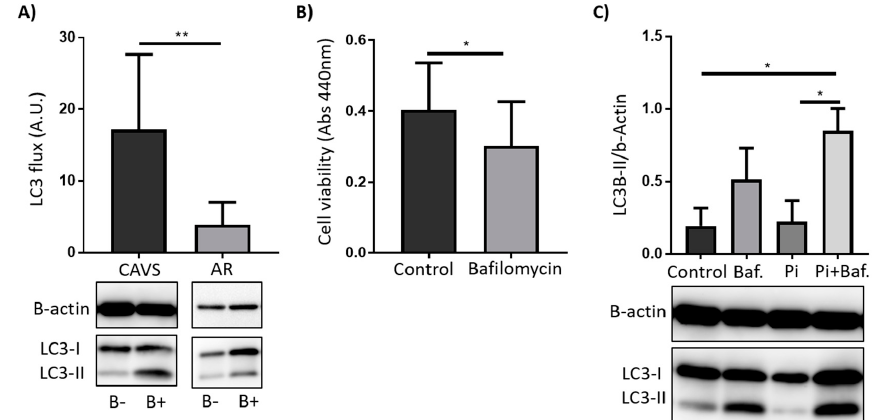
Figure 3. Autophagic activity is differentially expressed in AR and in CAVS and serves as a survival mechanism in valvular interstitial cells (VICs). ( A ) Immunoblotting against LC3-I and LC3-II in human VICs treated for 2 h with bafilomycin (1nM) (B+) or vehicle control (DMSO) (B-), including quantification of the autophagic flux measured as the LC3-II ratio between (B+/B-)/ β -actin. CAVS: n = 5, AR: n = 4. ( B ) VIC viability from CAVS patients after 24 h treatment with bafilomycin (1nM) or vehicle control (DMSO) n = 7. ( C ) Immunoblotting against LC3-I and LC3-II in human VICs from CAVS patients treated for 2 h with bafilomycin (1nM) or vehicle control (DMSO) followed by 24 h treatment with 2.6 mM phosphate (Pi) or control (media) n = 4. Quantified as the densiometry of LC3-II/ β -actin. Data presented as mean ± S.D. * = p < 0.05, ** = p <0.01, *** = p < 0.001, **** = p < 0.0001.